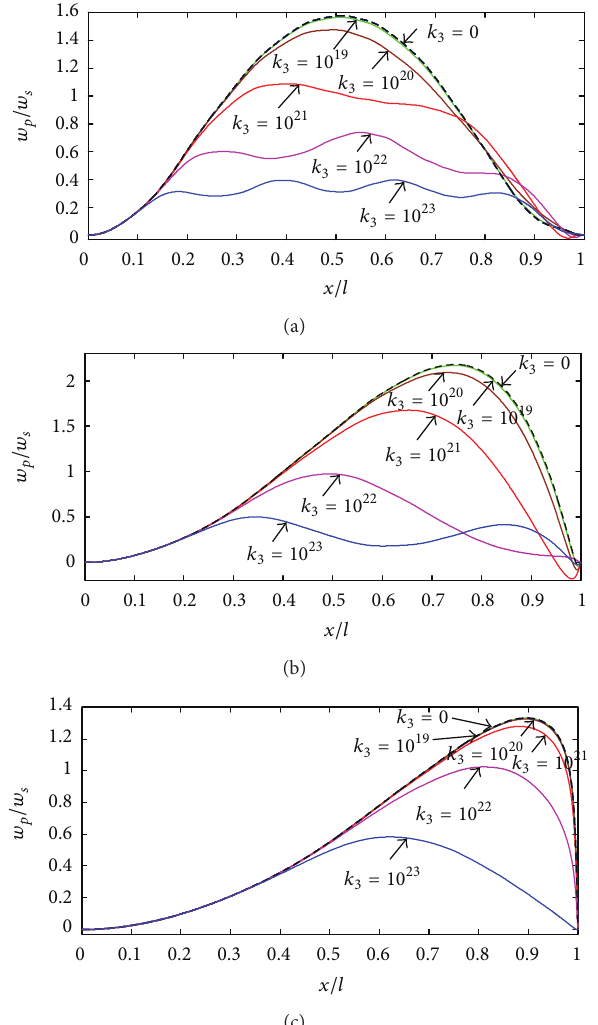
Figure 5: Variation of dimensionless instantaneous dynamic response, 𝑤 𝑝 /𝑤 𝑠 , versus normalized instantaneous position of mov- ing mass, 𝑥/𝑙 , of the Timoshenko beam with different 𝑘 3 values traveled at different speeds with 𝑚 = 3𝜌𝐴𝑙 kg, 𝑘 1 = 10 4 N/m 2 , 𝑐 = 10 3 N ⋅ s/m 2 , and 𝛽 = 0.3 . (a) 𝛼 = 0.11 , (b) 𝛼 = 0.25 , (c) 𝛼 = 0.5 ;